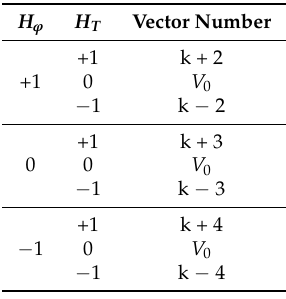
Table 3. Switching table of vector synthesis DTC [38].